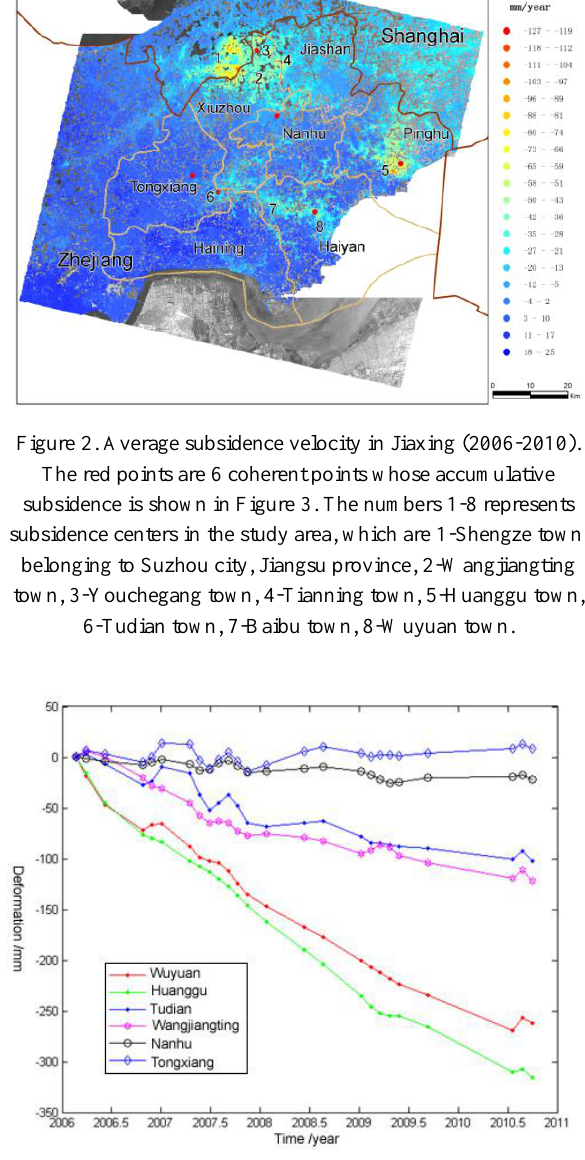
Figure 3. Accumulative subsidence of 6 coherent points from 2006 to